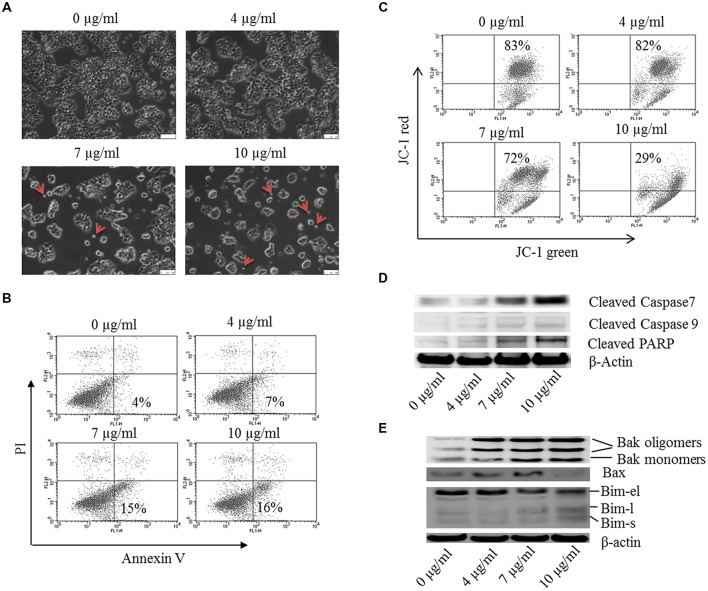
Bakuchiol induced apoptosis in MCF-7 cells. MCF-7 cells were treated with 0–10 μg/ml of bakuchiol for 24 h. (A) Morphology observation of bakuchiol treated MCF-7 under bright field. Small apoptotic bodies are labeled with red arrows. The white bar indicates 100 μm. (B) Representative flow cytometry results of annexin V/PI analysis. (C) JC-1 staining for analysis of mitochondrial membrane potential. Western blot analysis of expression levels of (D) Caspase family protein, including Cleaved Caspase 7, Cleaved Caspase 9, and Cleaved PARP, and (E) Bcl-2 family protein, including Bak, Bax, and Bim. β-Actin was used as loading control.